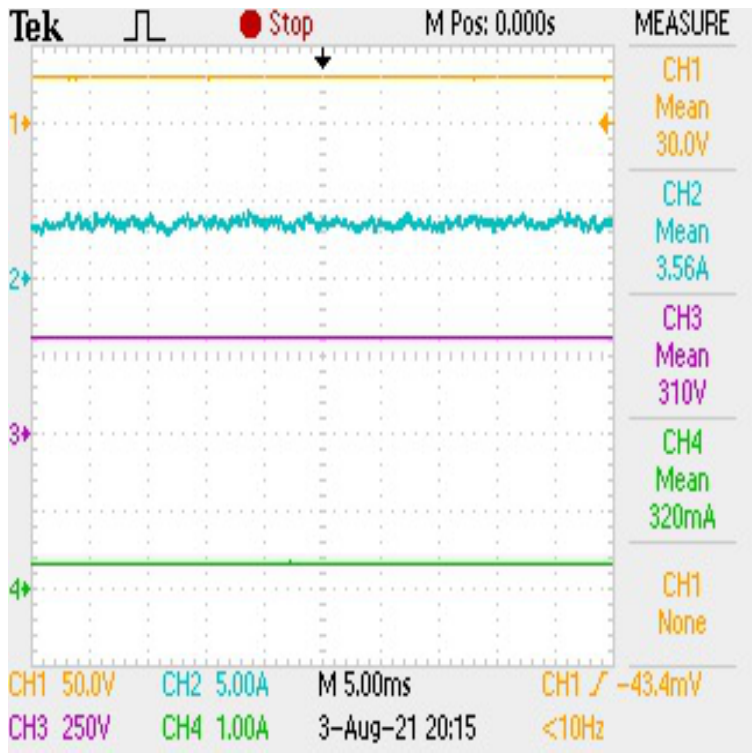
Figure 11. Input voltage, input current, output voltage and output